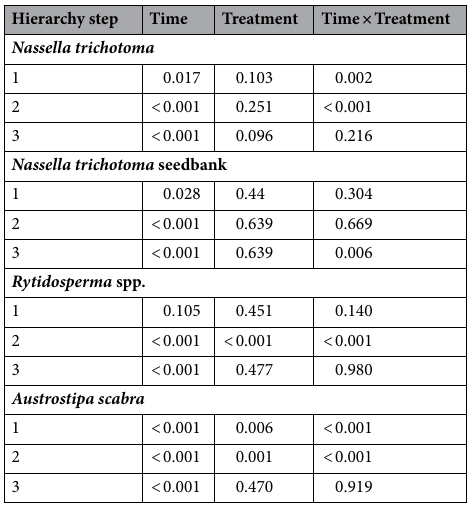
Table 4. The results of the hierarchy analysis using the developed flowchart (Fig. 1). Each species was analysed separately and the analysis of the effect of the treatment combination, sample period and the interaction of these factors are shown. Significance was set to p = 0.05.